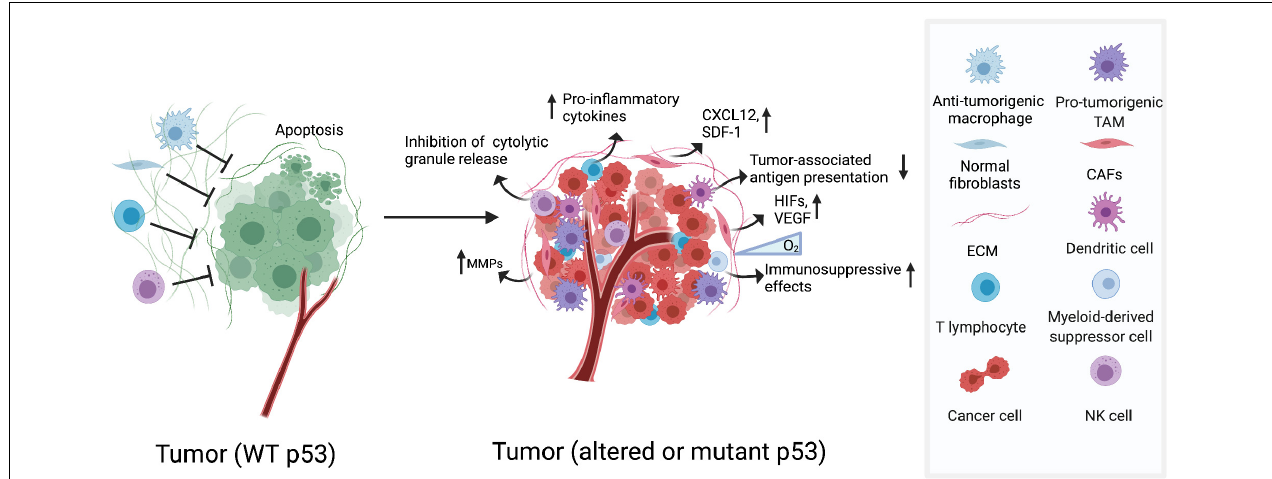
FIGURE 1 | Dysfunction of p53 shapes its immunogenic niche. The TME contains cellular and molecular components that shape immunological landscape of growing tumors. Altered or mutant p53 functions in CAFs increases expression of chemokines and cytokines, which drives tumor invasion and malignancy. In hypoxic tumor environments, GOF mutp53 cooperate with HIF-1 promoting expression of a subset of protumourigenic genes which participate in the rearrangement of ECM. In myeloid cells, p53 deficiency helps to accelerate tumourigenesis. Deletion of p53 in T cells increases the expression of pro-inflammatory cytokines which could help to enhance tumor